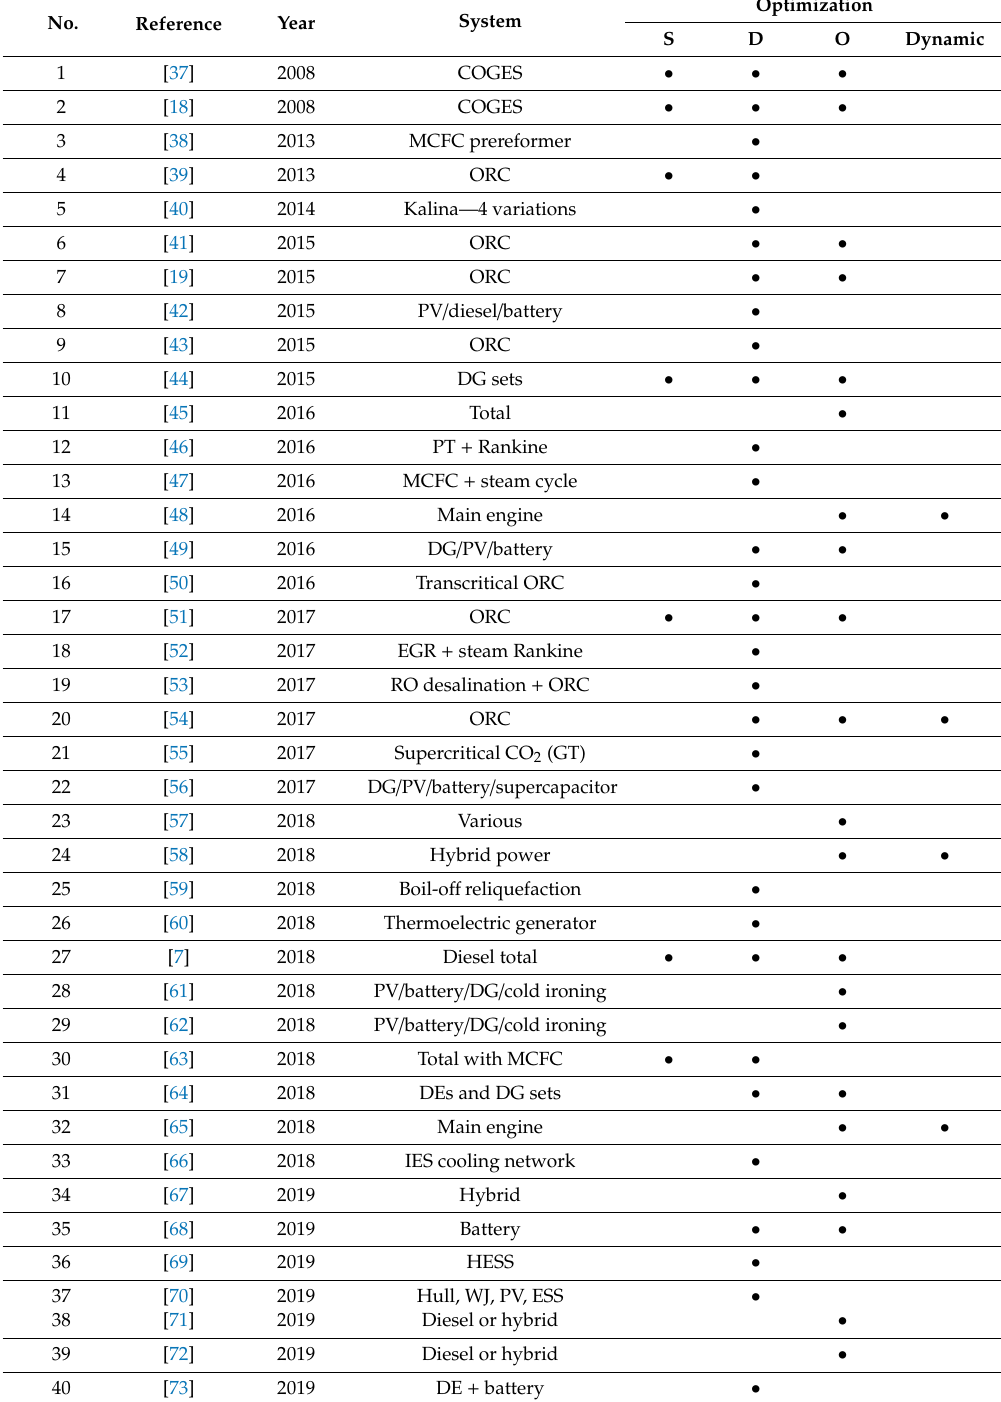
Table 1. Journal articles on optimization of energy systems of ships by the year of publication. (Explanations of symbols and abbreviations are written after Section 7